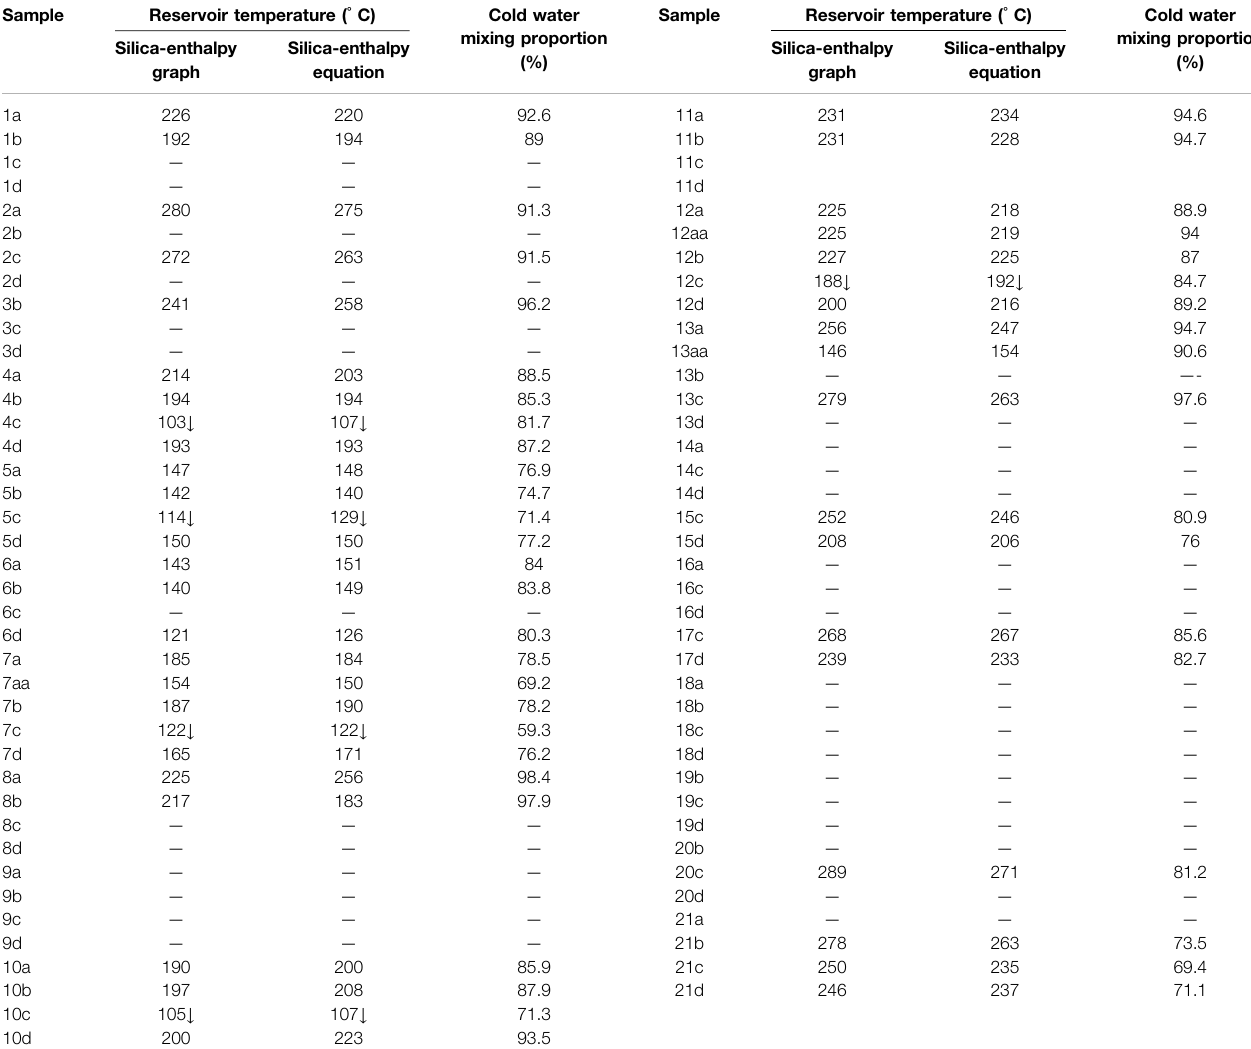
TABLE 2 | Reservoir temperatures based on the silica-enthalpy mixing model and cold water mixing proportions of the hot springs in the Simao Basin. Sample Reservoir temperature ( °